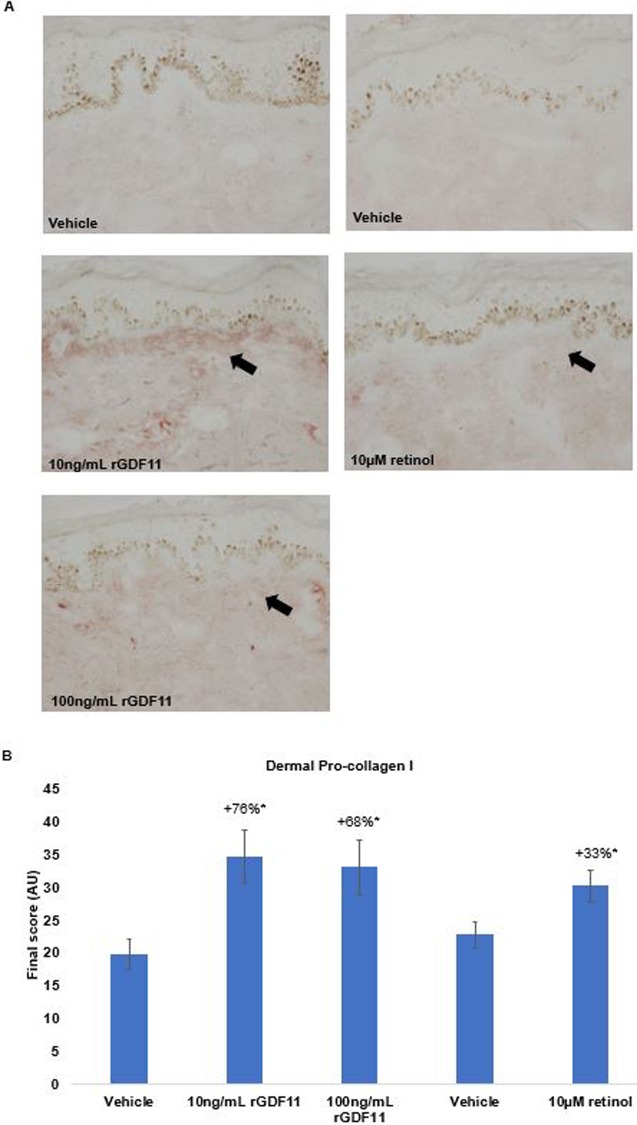
Effect of rGDF11 on procollagen I production in human skin explants.(a) Representative images of dermal procollagen I immunostaining. Replicate (n = 8) skin explants were cultured for 6 days in modified Williams’ E medium and treated daily with rGDF11 (added to the media at concentration of 10 ng/ml or 100 ng/ml), retinol (10 μM, topical 4μL), or corresponding vehicle. Twelve sections were immunostained and the amount of procollagen I was determined by image analysis. (b) Comparison of procollagen I scores assigned to sections (n = 12) treated with rGDF11, retinol, or vehicle. Results are shown as the mean +/- SEM; * indicates the change versus vehicle is statistically significant at p ≤0.05. Statistical analysis used: One-way ANOVA with permutation test: F (4,55) 4.35; p-value <0.01, followed by Tukey’s permutation test.